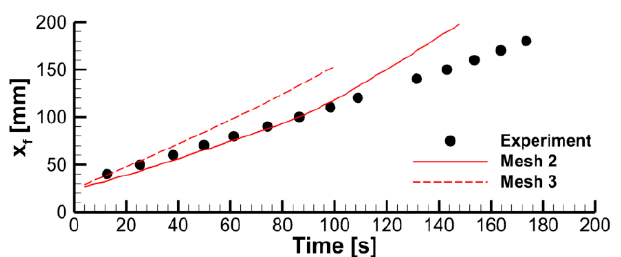
Figure 6. The effect of mesh refinement on predicted flame propagation dynamics. Flame front coordinate is defined as the distance from the upper edge of the specimen to the flame front at the vertical centerline.